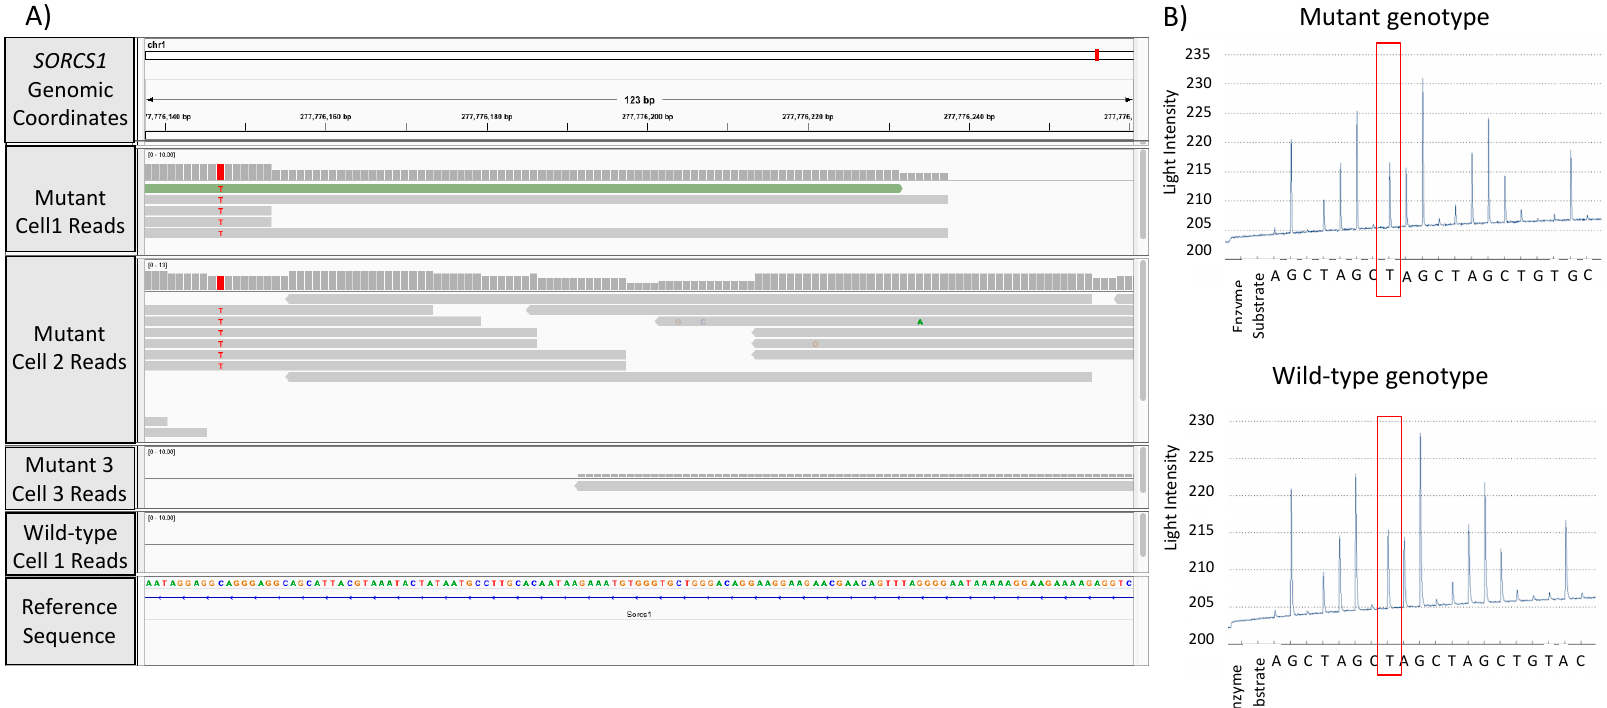
Figure 4. Visualization of mutations detected in the GATK/GWAS pipeline and validation of the pipeline by genomic DNA sequencing of samples using pyrosequencing. ( A ) Genome browser visualization of single-cell RNA-Seq reads spanning the SORCS1 gene in mutant (mHTT) and wild-type cells. The figure shows mutant samples with zero, five and six reads spanning the SORCS1 locus; ( B ) confirmation of detection of C>T substitution in the DNA sequence by pyrosequencing in SORCS1 .